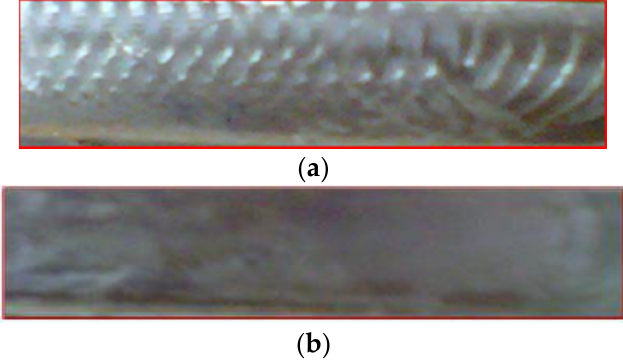
Figure 4. ( a ): Aluminum blocks — m achine configuration 11: Ra = 1.16 µm ( speed 2000 rpm, feed 500 mm/min, radial depth 1.5 mm, and axial depth 20 mm); ( b ) m achine configuration 13: Ra = 0.5 µm (speed 2000 rpm, feed 100 mm/ min, radial depth 1.5 mm, and axial depth 20 mm). Table 1. Experimental data.